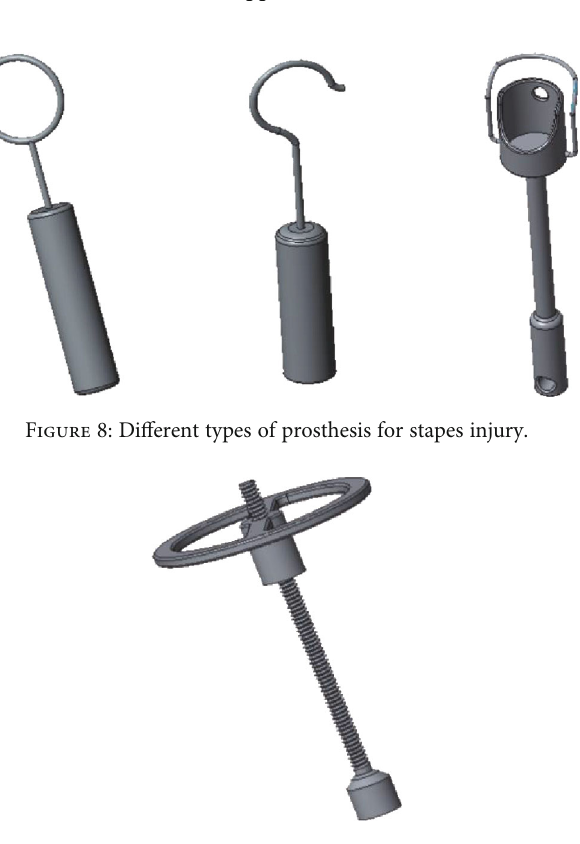
Figure 9: Stapedectomy with incus prosthesis.